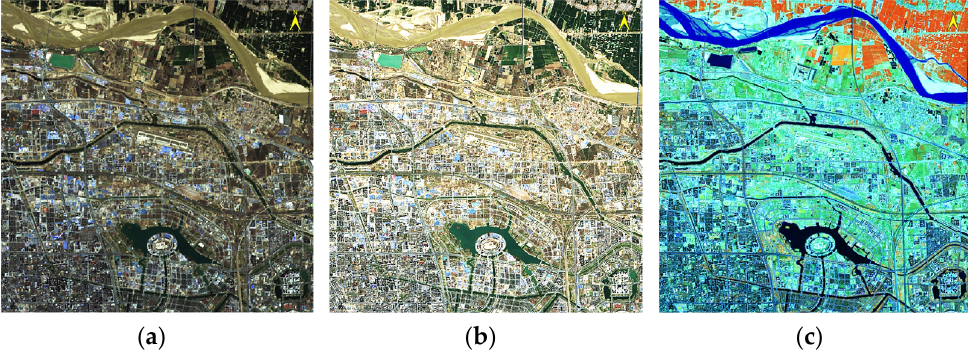
Figure 6. Raw remote sensing images are preprocessed to produce ( a ) brovey transformed image, ( b ) corrected image, and ( c ) false color composite image.